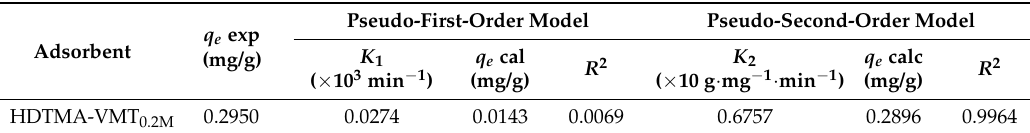
Table 3. Parameters for pseudo-first-order and pseudo-second-order kinetic models.